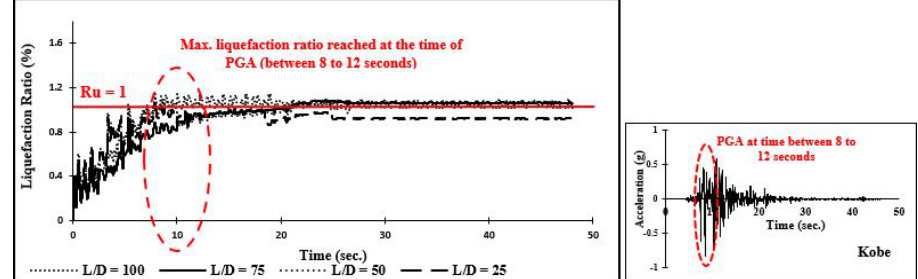
Figure 6: The liquefaction and acceleration time history